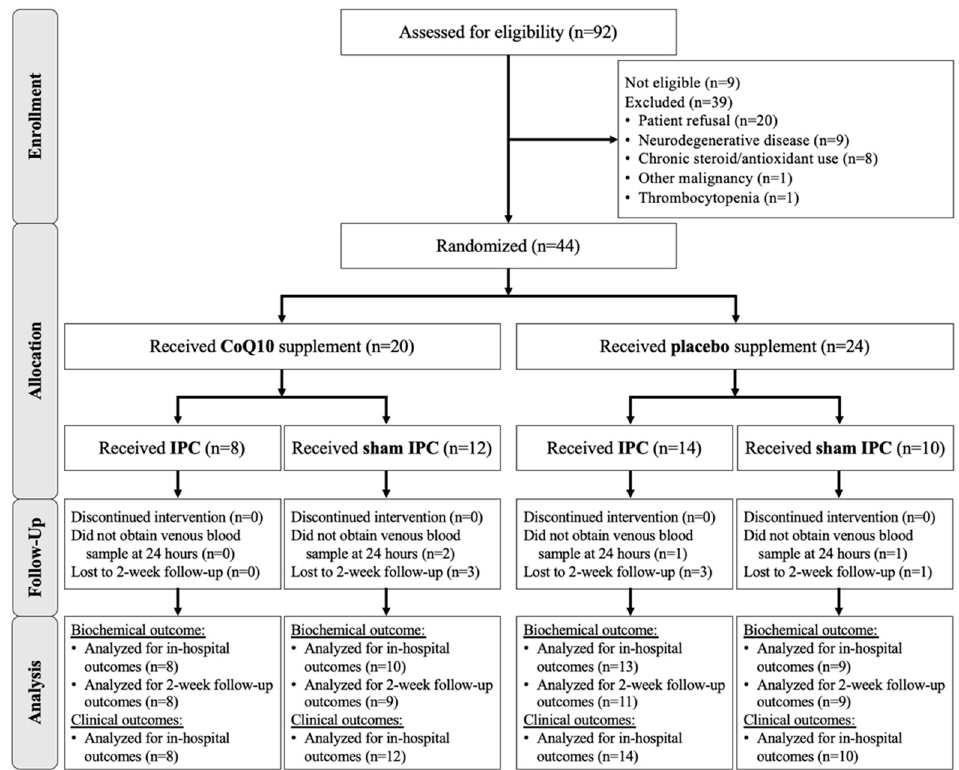
Figure 2. CONSORT flow diagram for screening, inclusion, exclusion, and lost to follow-up of the study participants. Table 1. Demographic data of knee osteoarthritis patients receiving placebo vs. CoQ10.